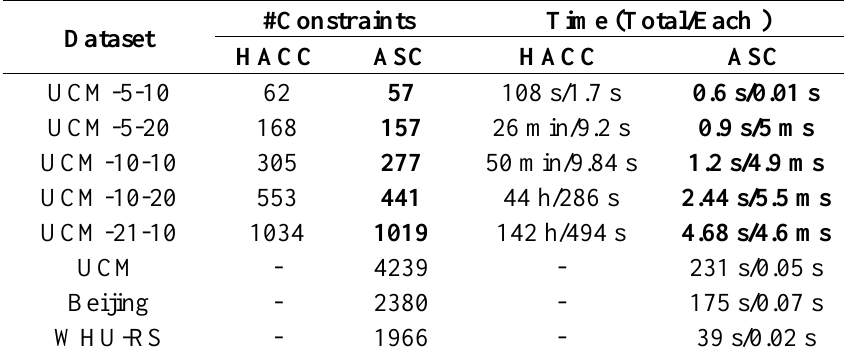
Table 2. Results achieved on sub-datasets.